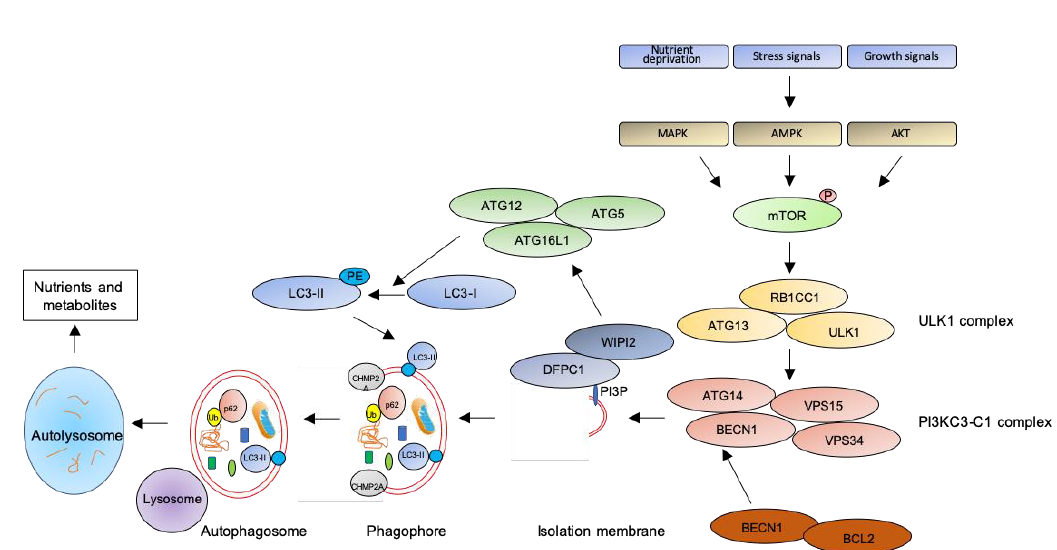
Figure 1. The autophagic pathway. See text for details.